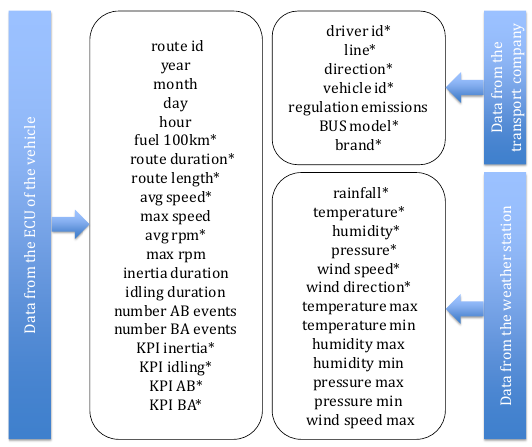
Figure 3. Available parameters with external data integration. The variables included in the model are marked with ‘*’.